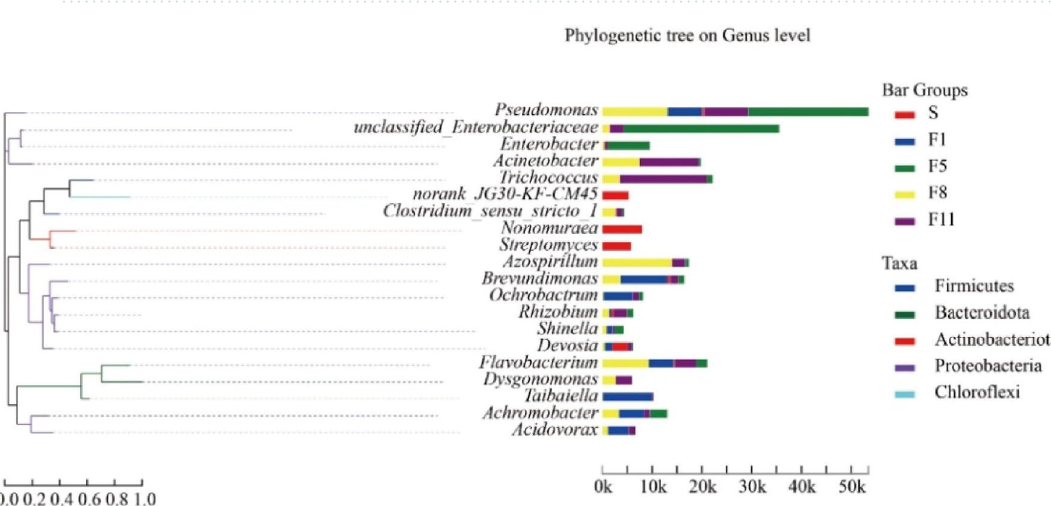
Figure 7. The ( a ) circos cluster analysis of dominant genera and ( b ) different analyses at the genus level.